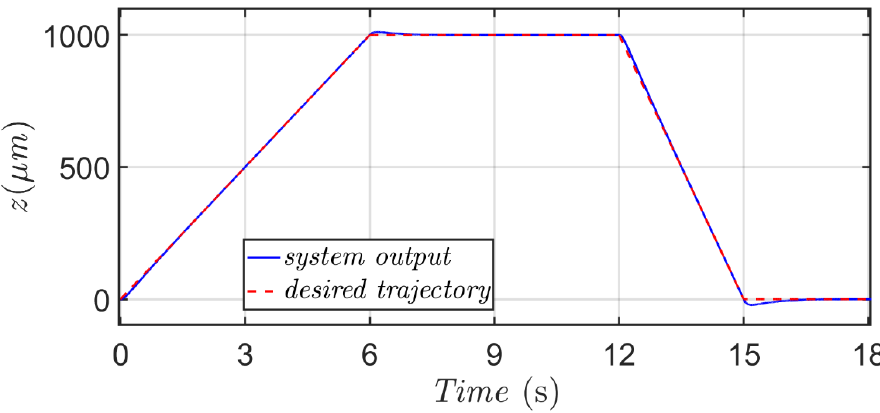
Figure 17. History of the proposed micro-positioning actuator for a desired trapezoidal-type trajectory.